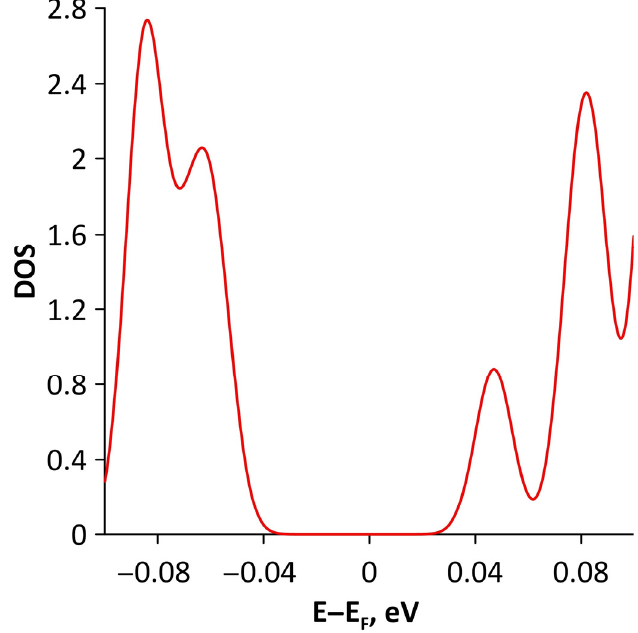
Figure 7. Fragment of DOS near the Fermi level (shifted to 0 eV) of borophene/GaN heterostructure under uniaxial compression by 14%.